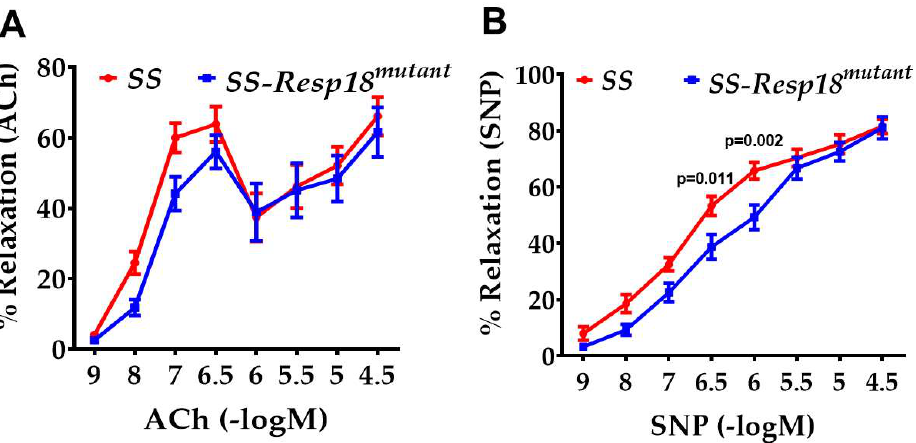
Figure 1. SS- Resp18 mutant rats have vascular dysfunction after six weeks of a high-salt diet: Concentration–response curve to ( A ) acetylcholine (ACh) and ( B ) sodium nitroprusside (SNP) in mesenteric arteries isolated from SS and SS- Resp18 mutant rats ( n = 4–6/group). Values are mean ± SEM. p = 0.011, p = 0.002 vs. SS- Resp18 mutant , two-way ANOVA (Sidak test).